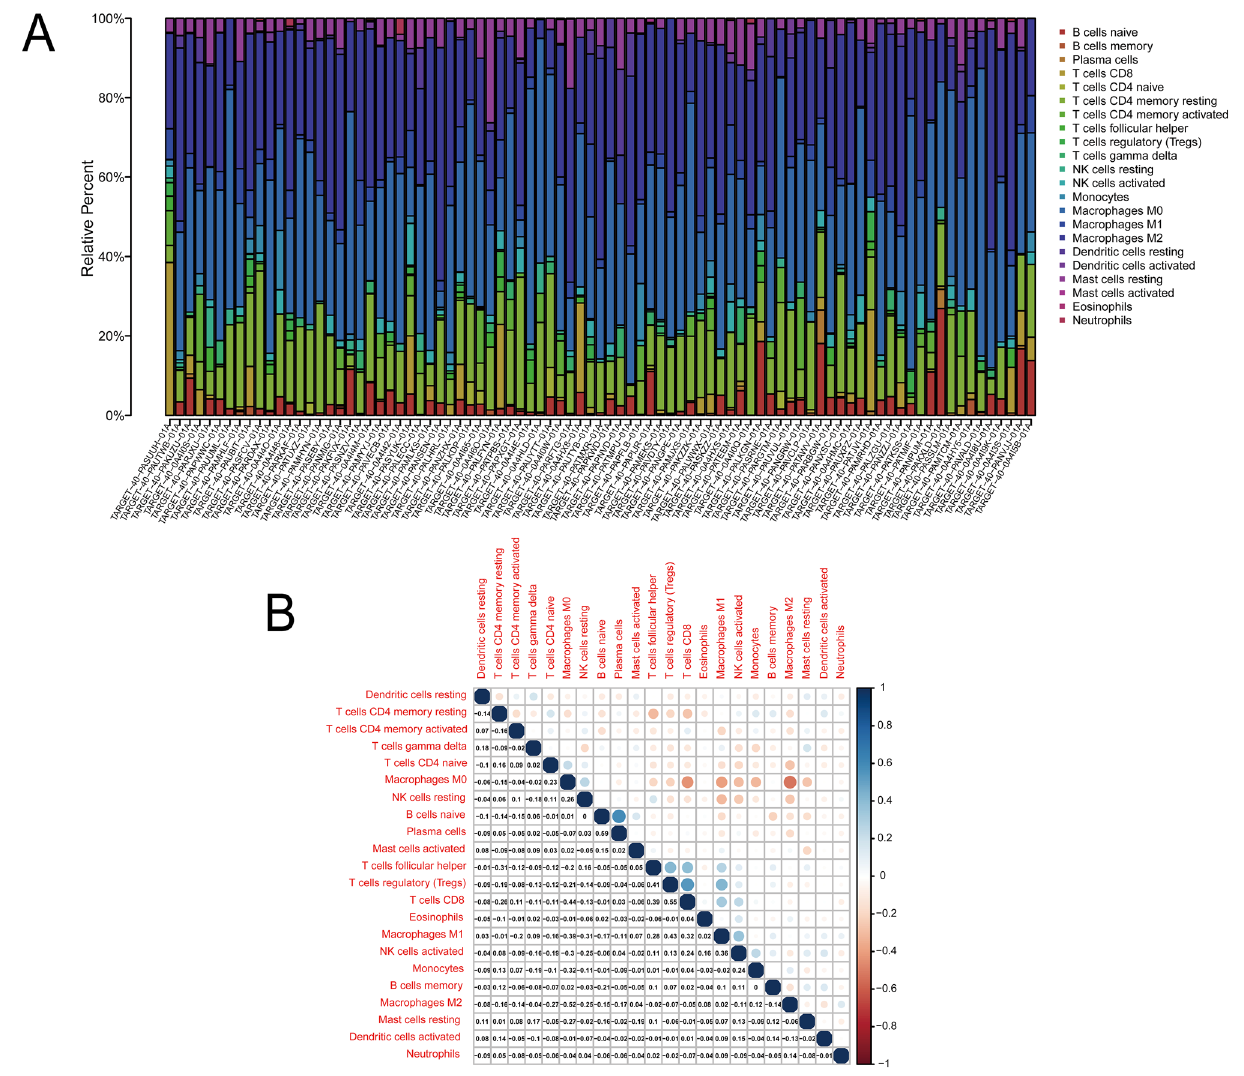
Figure 4. Immune cell composition and correlation analysis of osteosarcoma. ( A ) The proportion of 22 immune cells in osteosarcoma. ( B ) The correlation matrix between various immune cells; red represents positive correlation, and blue represents negative correlation, a darker color indicates stronger